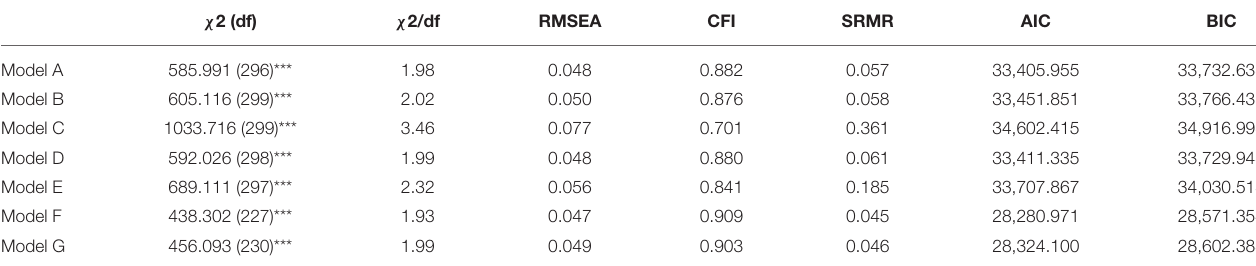
TABLE 3 | Confirmatory factor analysis (CFA) model fit summary.